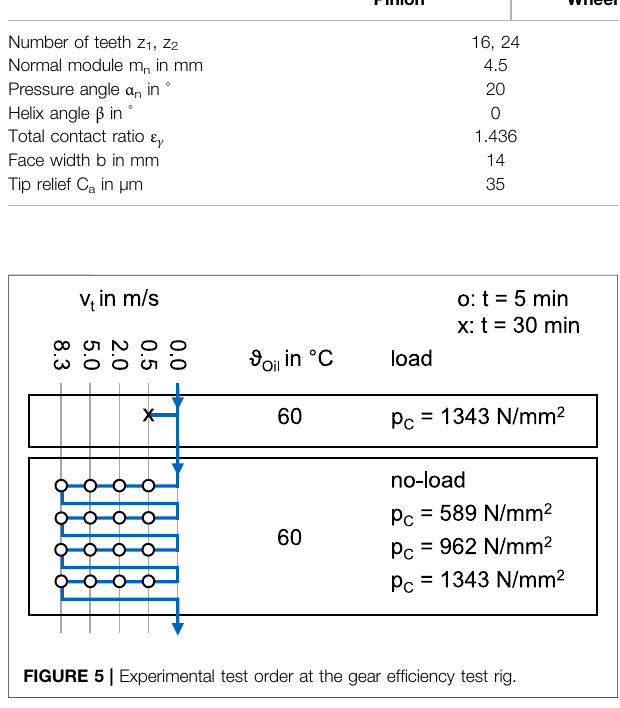
TABLE 3 | Investigated pinion torques, wheel torques and Hertzian pressures at the gear ef fi ciency test